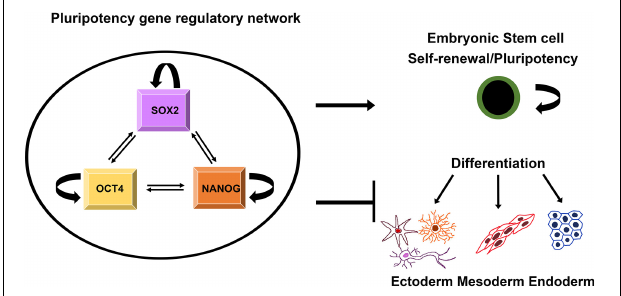
FIGURE 1 | Schematic illustration of regulatory network that controls pluripotency, self-renewal and differentiation. SOX2, NANOG, and OCT4 regulate their own expression targeting both their own promoters and those of each other. The triad contributes to maintaining pluripotency of ESCs by activating genes involved in pluripotency and by repressing genes linked to lineage commitment (Scheper and Copray,